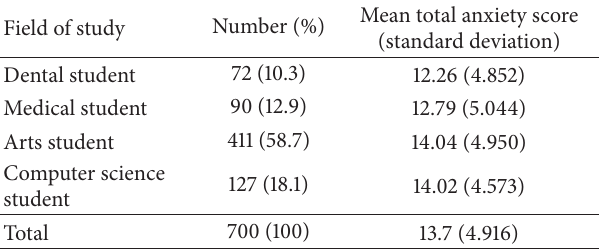
Table 2: Distribution of the study sample by the field of study and the mean total anxiety score ( 𝑛 = 700